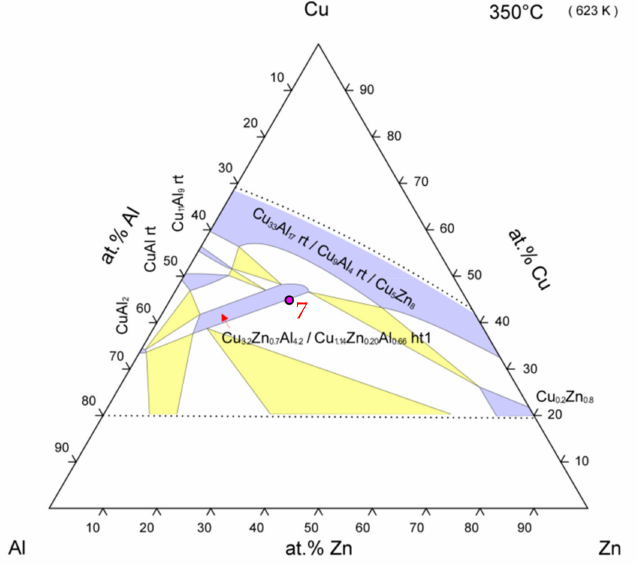
Figure 17. Isothermal sections in the ternary system of Al–Cu–Zn for the temperature of 350 ◦ C with marked position of Spectrum